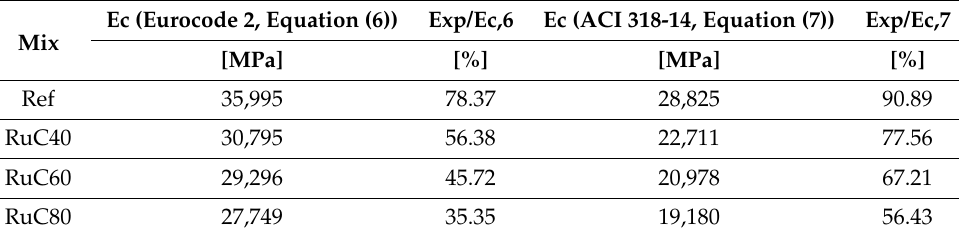
Table 4. Predicted values for the static modulus of elasticity as function of the compressive strength.